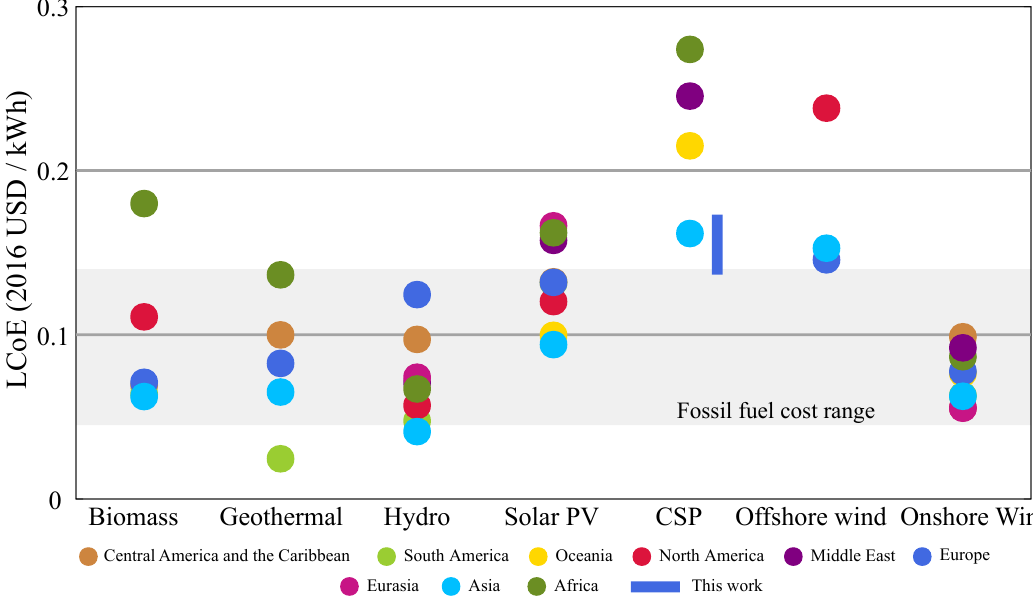
Figure 17. Regional weighted average LCoE for different renewable power generation technologies [49]. Data correspond to 2016 and 2017. The results obtained for the solar Brayton dish in this work are shown as a blue bar. The shaded area indicates the fossil fuel cost